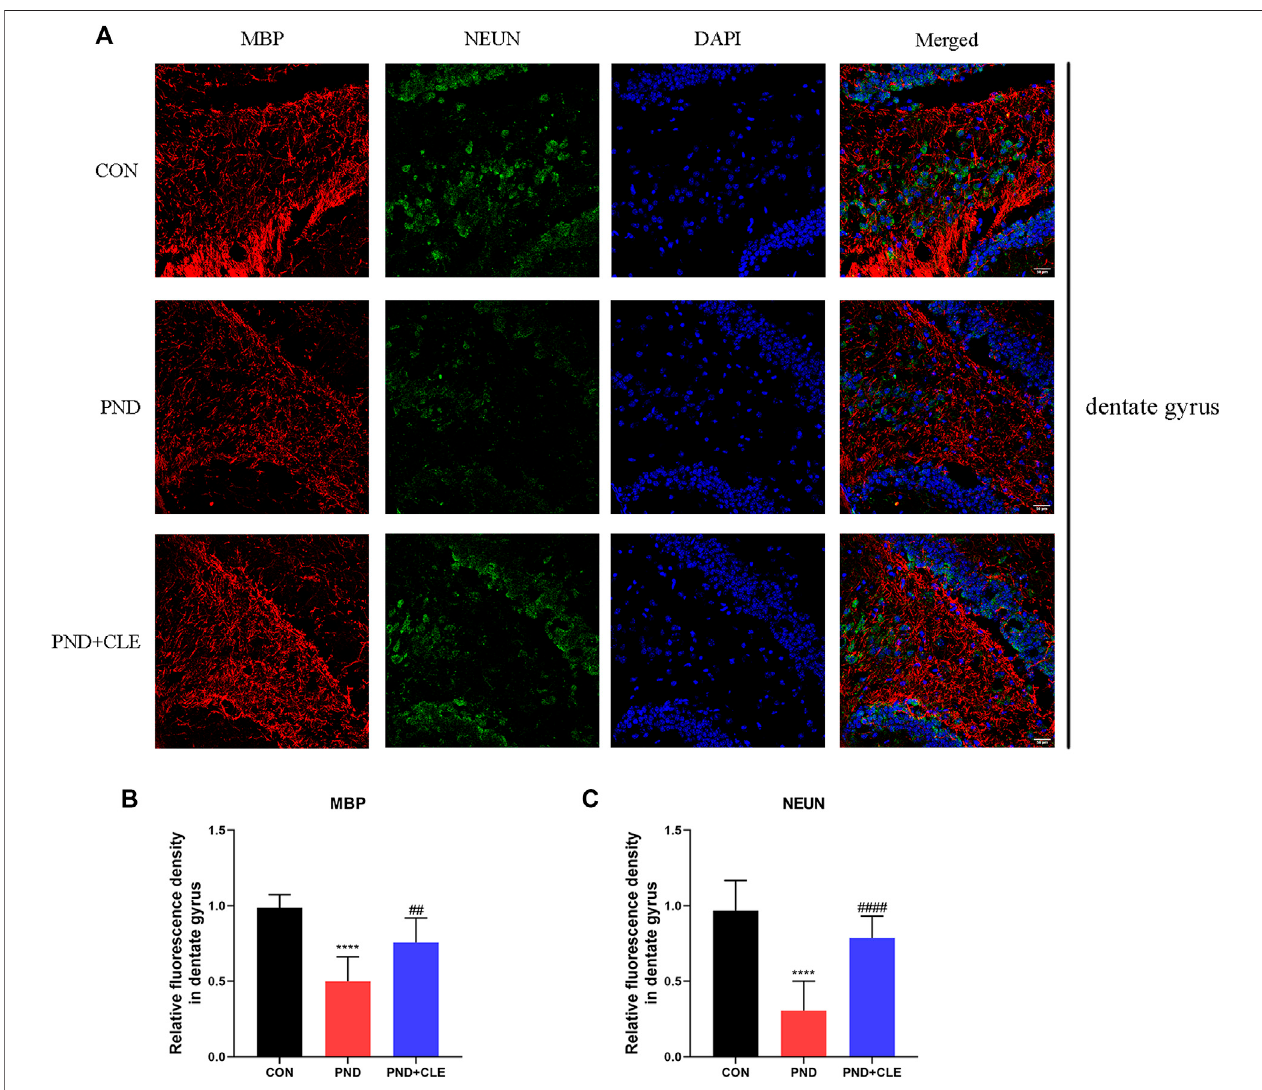
FIGURE7| Immuno fl uorescenceanalysisdetectedMBPandNEUNproteinlevelsinhippocampal dentate gyrus(scalebar (cid:1) 50 µm).( A )Representativeimagesof MBP andNEUNin thedentate gyrus. ( B )Mean fl uorescencedensity ofMBPinthedentate gyrus.( C )Mean fl uorescencedensity ofNEUN inthedentate gyrus. Thedata arepresentedasmean ± S.D.( n (cid:1) 10micepergroup).**** p < 0.001compared withtheCONgroup. ## p < 0.01comparedwiththePNDgroup. #### p < 0.001compared with the PND